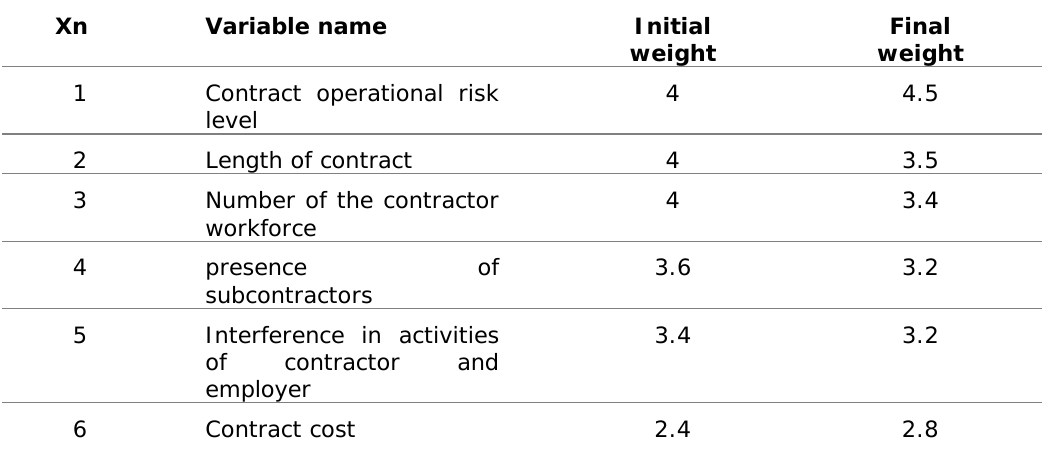
Table 4. Initial and final weights of the contract separation